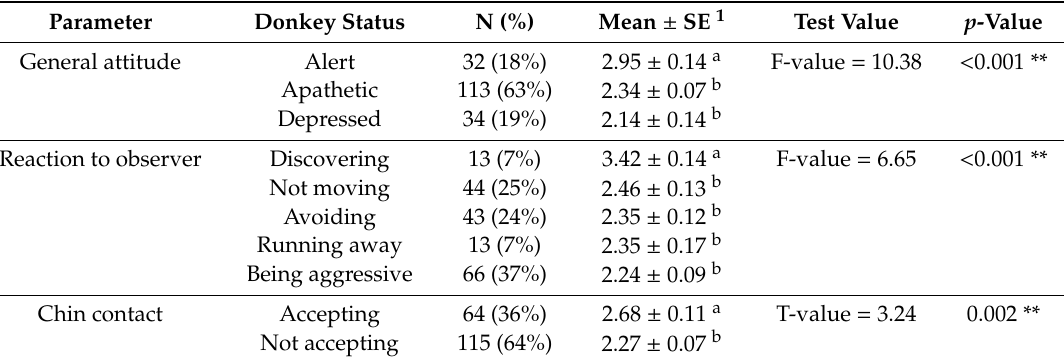
Table 5. Numerical summary of body condition for di ff erent statuses of general attitude, reaction to an observer, and chin contact, along with the statistical test values and p -values of the t-test and ANOVA test.